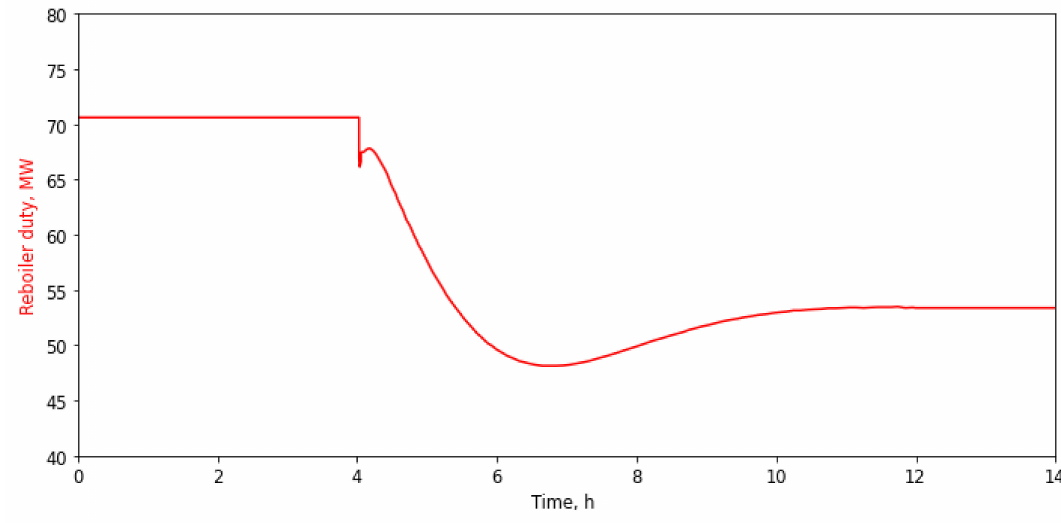
Figure 11. Reboiler duty (MW) stabilizing